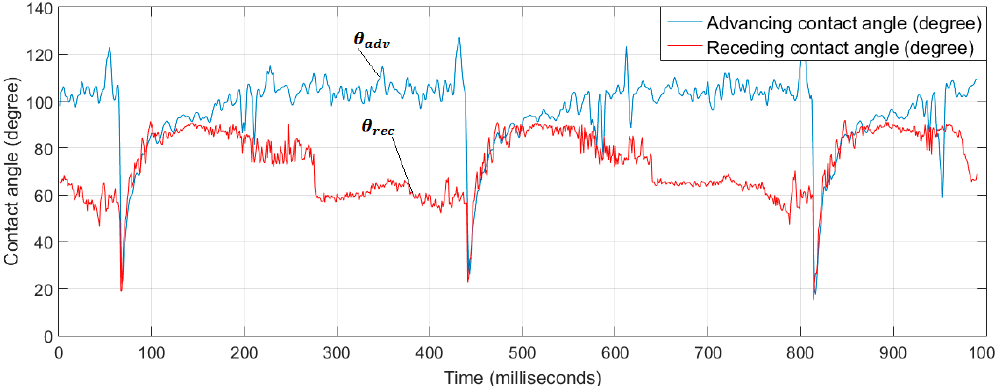
Figure 13. Slug advancing (blue line) and receding (red) contact angle results from image processing.